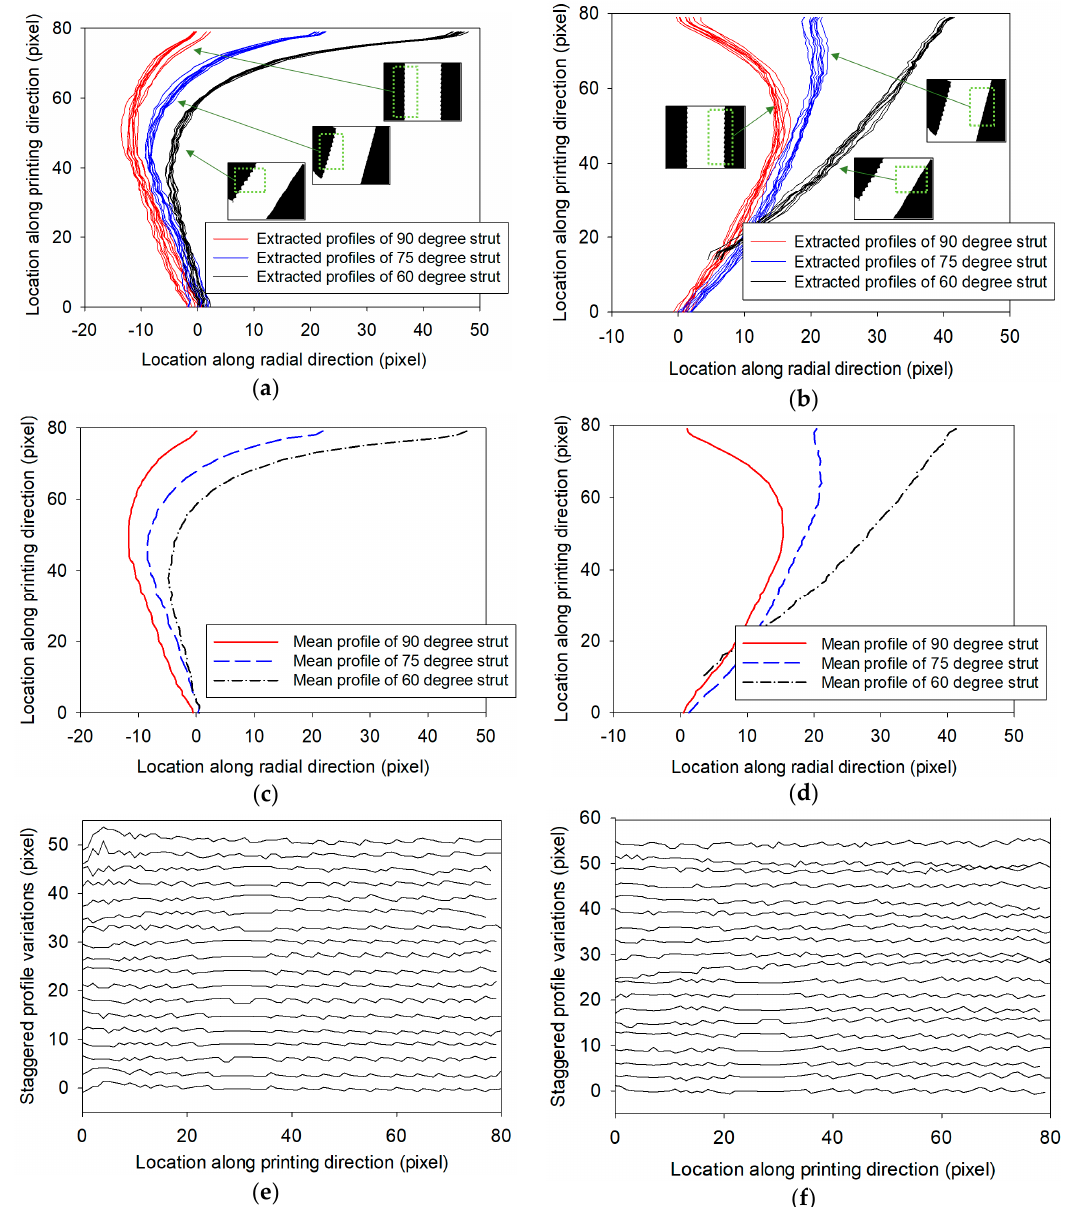
Figure 5. Extracted sidewall profiles of additively manufactured struts: ( a ) The extracted left-sidewall profiles in different angles (90°, 75°, and 60°); ( b ) The extracted right-sidewall profiles in different angles (90°, 75°, and 60°); ( c ) Extracted left-sidewall mean profiles in different angles (90°, 75°, and 60°); ( d ) Extracted right-sidewall mean profiles in different angles (90°, 75°, and 60°); ( e ) Extracted left-sidewall roughness profiles after clean-up; ( f ) Extracted right-sidewall roughness profiles after clean-up.